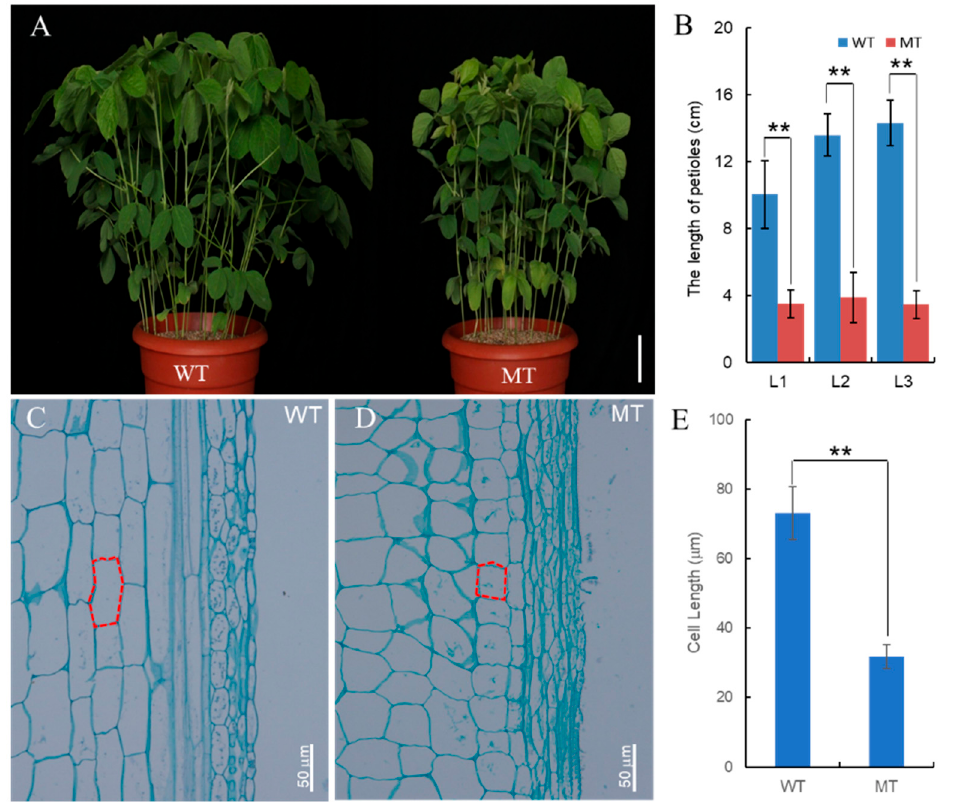
Figure 1. Phenotype comparison between wild-type (WT) and spwp mutant-type (MT) plants. ( A ): Phenotype appearance of whole plants of the WT (left) and MT (right). The scale bar is 10 cm. ( B ): Comparison of petiole length from the first to third leaf position between the WT and MT. L1, L2, and L3 represent the first to third leaf petioles from the top to the bottom, respectively. ( C , D ): Longitudinal sections on the middle part of the petioles at the third node, counted from the top to the bottom of the WT ( C ) and MT ( D ) plants. The scale bars are 50 μ m. ( E ): Comparison of the single-cell length of the leaf petioles between the WT and MT. The result represents the average value of five consecutive cells in a single longitudinal cell file. Significant differences were determined using the Student’s t -test: ** p < 0.01. All data are given as mean ± SD.